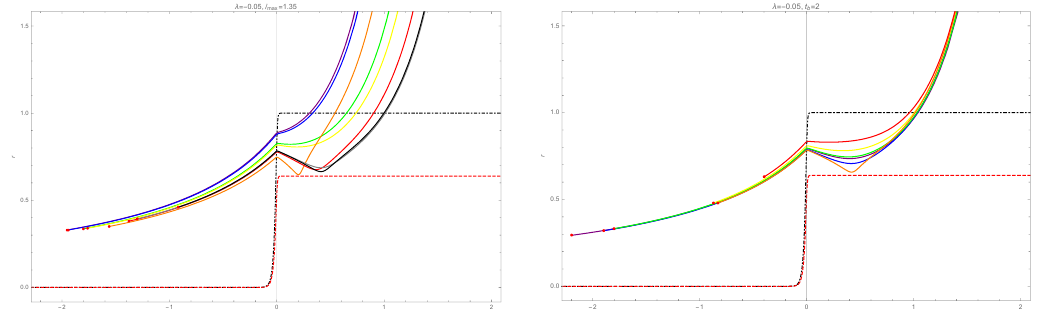
Figure 8 . Left panel: r vs v pro(cid:12)le of representative geodesics with (cid:21) GB = (cid:0) 0 : 05 and (cid:12)xed ‘ = 1 : 35. Right panel: r vs v pro(cid:12)le of representative geodesics with (cid:21) GB = (cid:0) 0 : 05 and (cid:12)xed t b = 2.